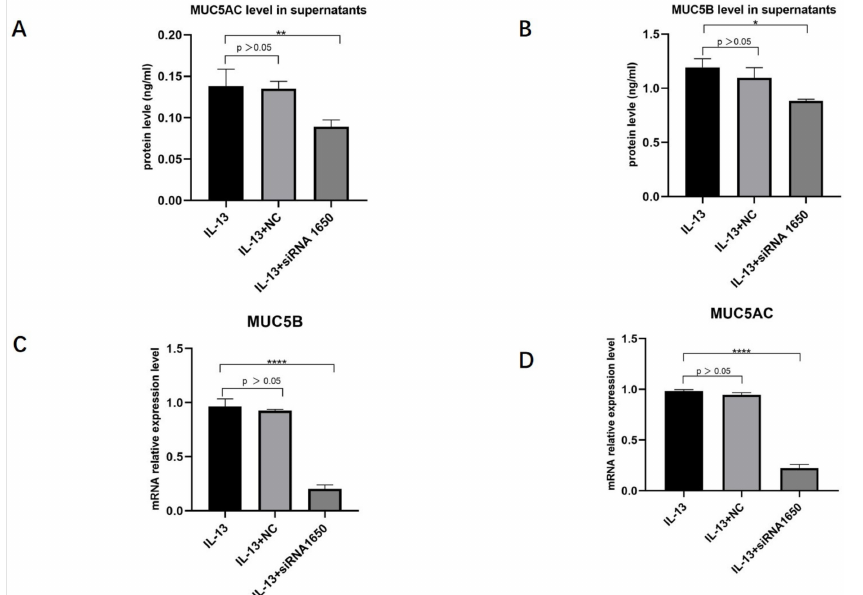
Figure 6. AfterIL-13 (50 ng/mL) stimulation and transfection with siRNA pendrin-1650, FAM NC, Western blot, and qRT-PCR revealed that the expression levels of MU5AC ( A , C ) and MUC5B ( B , D ) were downregulated. * represents p < 0.05, ** represents p < 0.01, **** represents p <